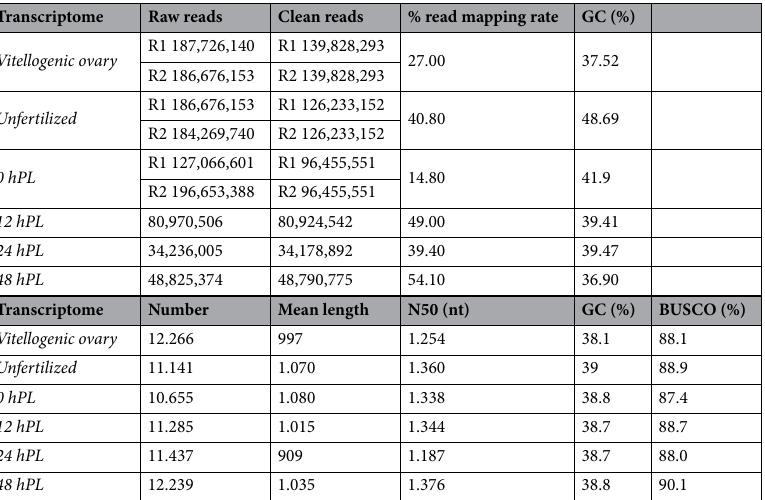
Table 1. Summary of the RNA-seq metrics from R. prolixus transcriptomes from vitellogenic ovaries, unfertilized and 0 to 48 hPL eggs. A : Raw Reads: the original sequencing reads counts; Clean Reads: number of reads after filtering; % read mapping rate: percentages of the overall mapping rate using the annotated genome as reference, % GC: percentages of G and C in total bases. B : Transcriptome assembly’s statistics, Number, number of the total of reconstructed transcripts; Mean length: the mean length in base pairs; N50: is the size of the transcript which, along with the larger transcripts, contain half of sequence of the reference; GC: percentages of G and C in total bases; BUSCO: percentages of the transcriptome completeness by BUSCO analysis